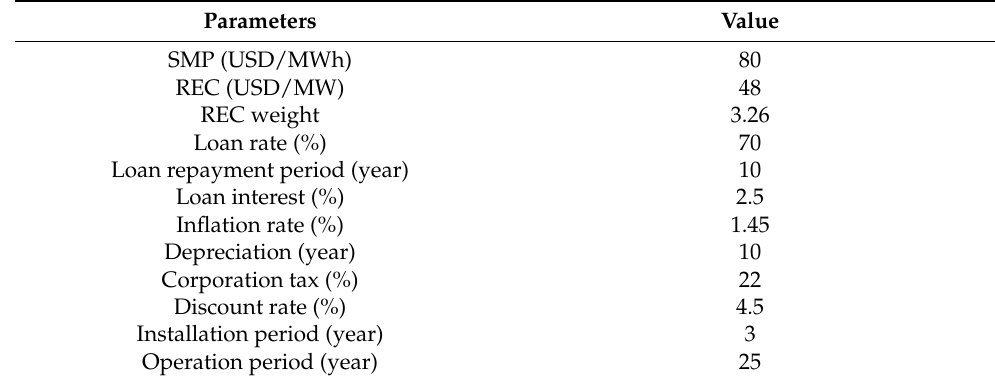
Table 17. The financial assumption for the evaluation of economic feasibility of the 200 MW class SCSG type FOWF.